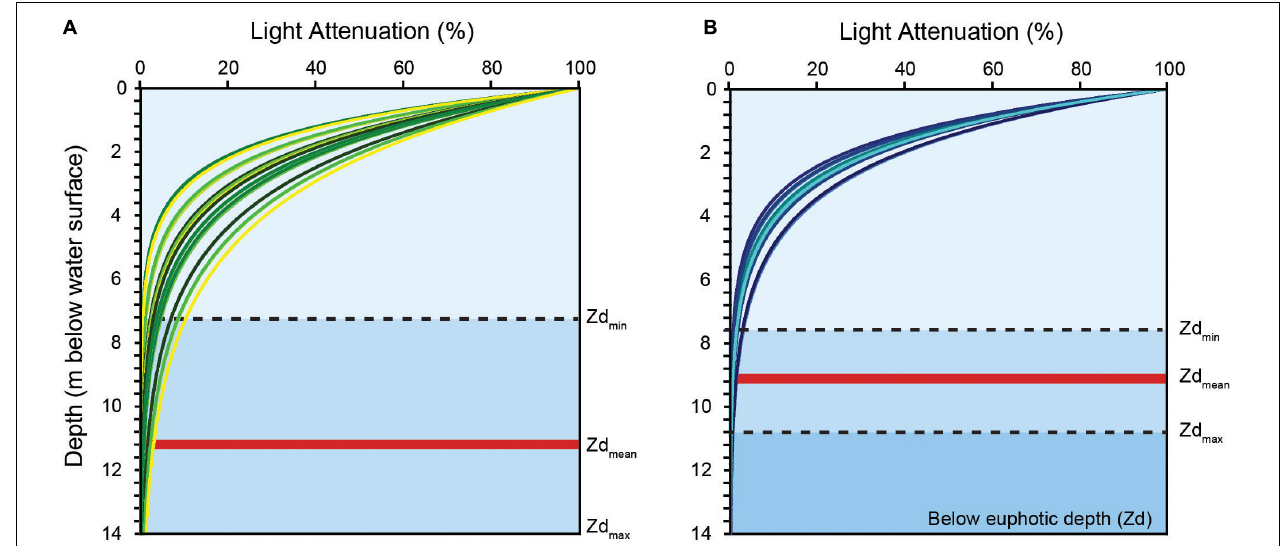
FIGURE 4 | Light attenuation (%) with depth (m) at (A) Kusu Island (green) and (B) Pulau Hantu (blue). Kd PAR values were derived from daily (at 1200 h) field measurements of Photosynthetic Active Radiation (PAR). Minimum, maximum and average euphotic depths (Zd) as 1% of surface PAR are shown.